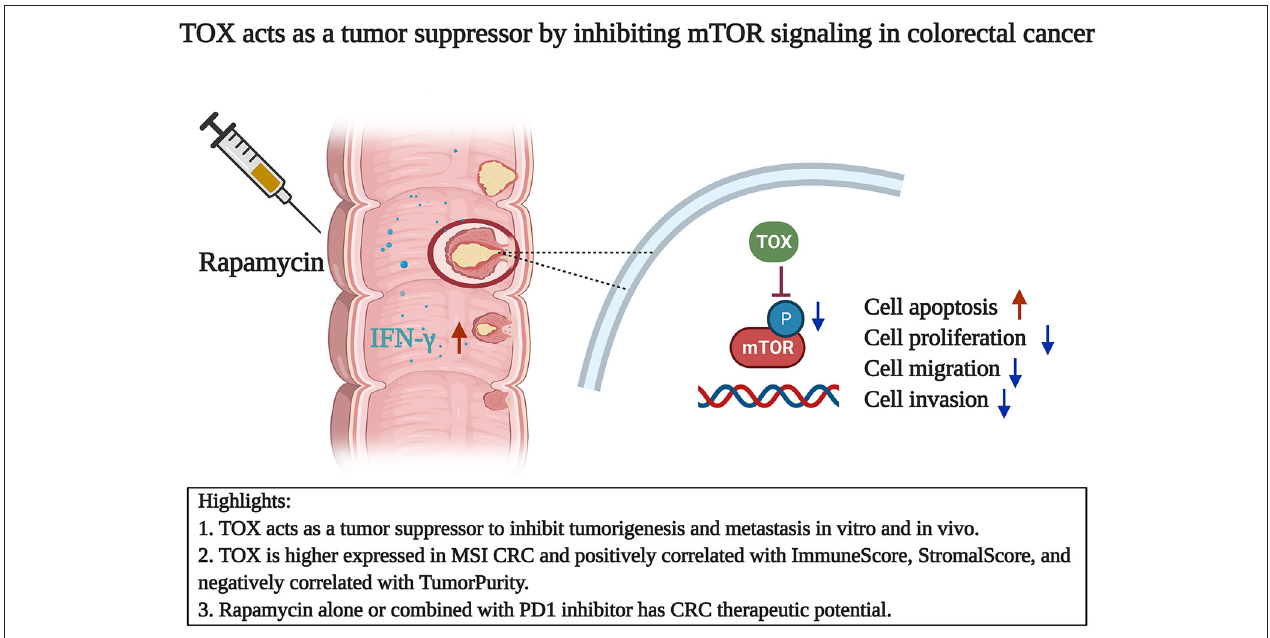
FIGURE 8 | TOX acts as a tumor suppressor by inhibiting mTOR signaling in colorectal cancer. TOX acts as a CRC suppressor with decreasing expression and longer OS. TOX partly suppressed the mTOR signaling to inhibit cell proliferation, migration, invasion, and EMT process. Rapamycin alone or combined with PD1 inhibitor has therapeutic potential in